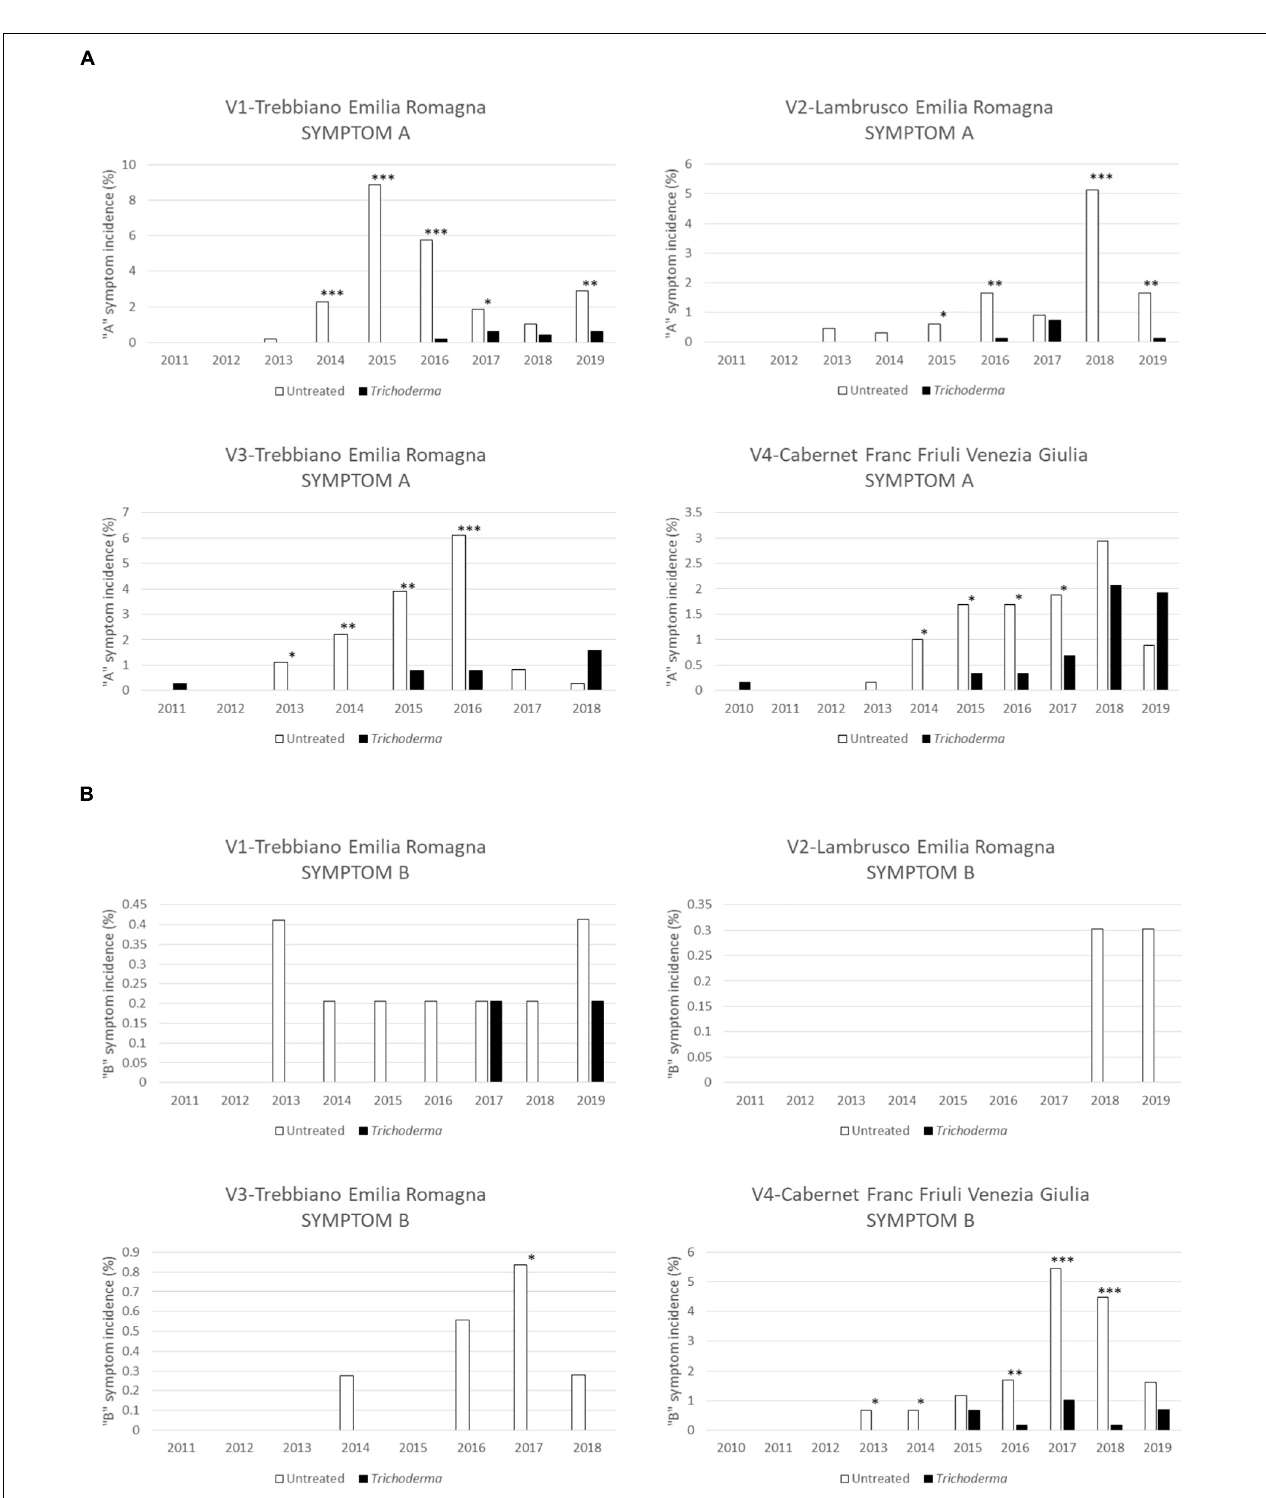
FIGURE 5 | Severity of foliar symptoms in the four young asymptomatic vineyards monitored for 8–10 years: Symptom “A”—low severity (A) and symptom “B”—high severity (B) were analyzed by χ 2 test. All the plants of each plot were considered to compare Trichoderma and control treatments. Where differences in distribution between the two treatments were significant, asterisks were placed ( ∗ P < 0.05, ∗∗ P < 0.01, and ∗∗∗ P < 0.001 significance levels, respectively).